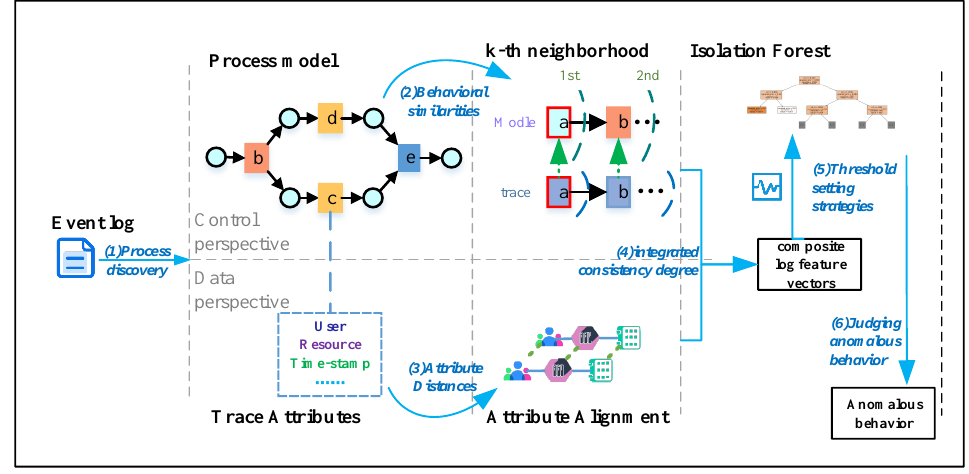
Figure 1. Overview of research methods, inputs, and